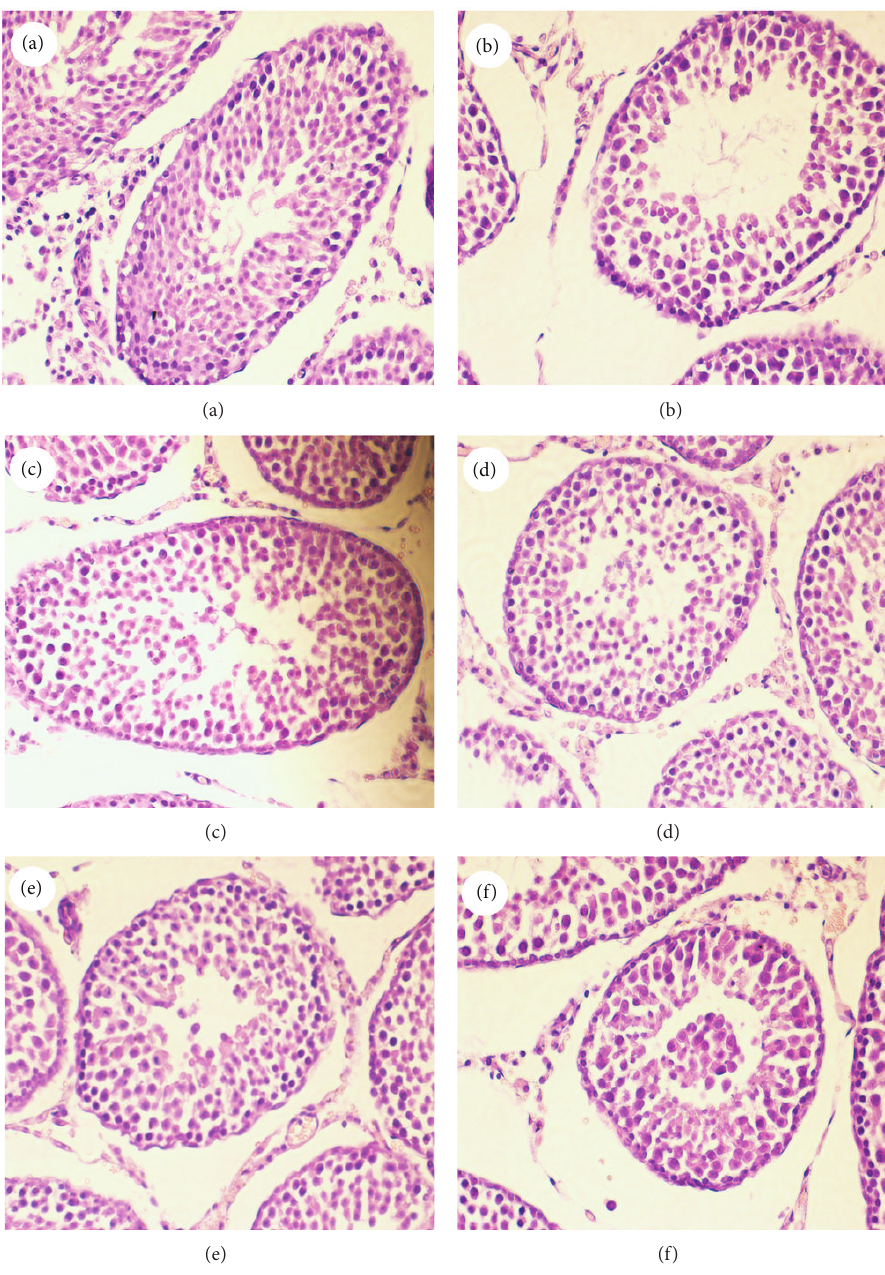
Figure5:LightmicroscopeobservationsofH&Estainedsections( × 200).(a)Shamgroup:normaltesticulararchitecturewasseen.(b)Torsion group and (c) torsion/detorsion (T/D) group: severe damage to testis was noted. (d), (e), and (f): T/D + LXA4 subgroup 1–3,